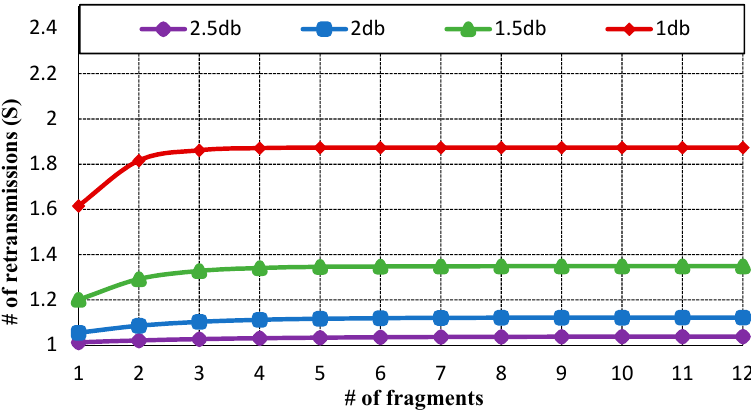
Figure 3. Average number of retransmission counts for f fragmented CoAP messages.